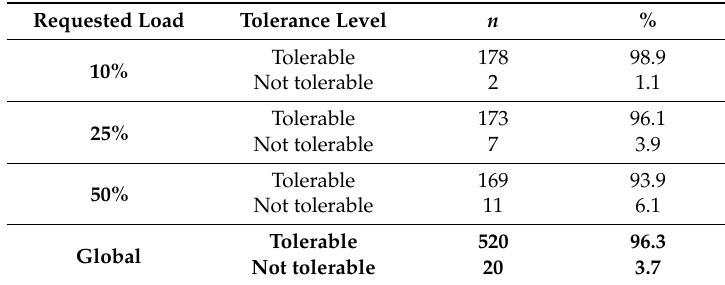
Table 4. Frequencies and load percentages of adjustment for the tolerance levels according to the Bland–Altman method. ( n = number of measurements).